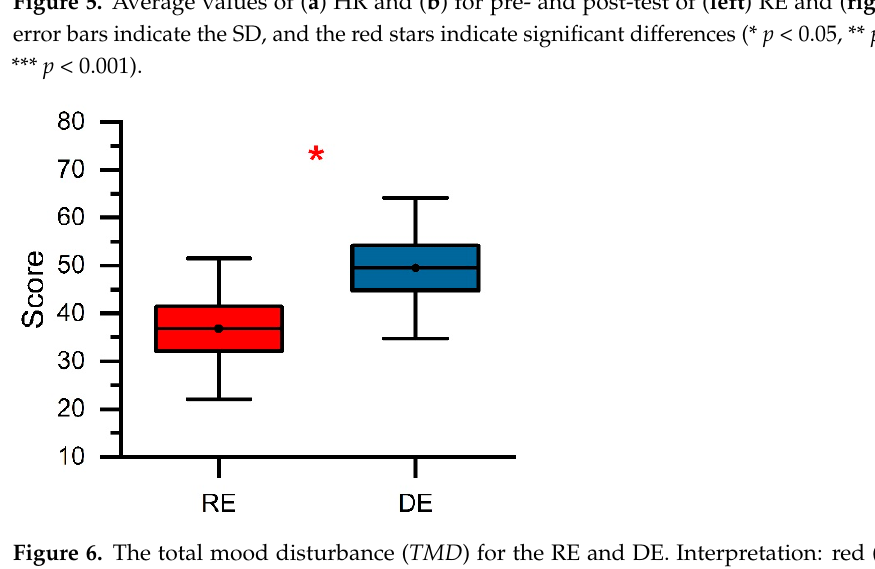
Figure 5. Average values of ( a ) HR and ( b ) for pre- and post-test of ( left ) RE and ( right ) DE. The error bars indicate the SD, and the red stars indicate significant differences (* p < 0.05, ** p < 0.01 ,and *** p < 0.001).